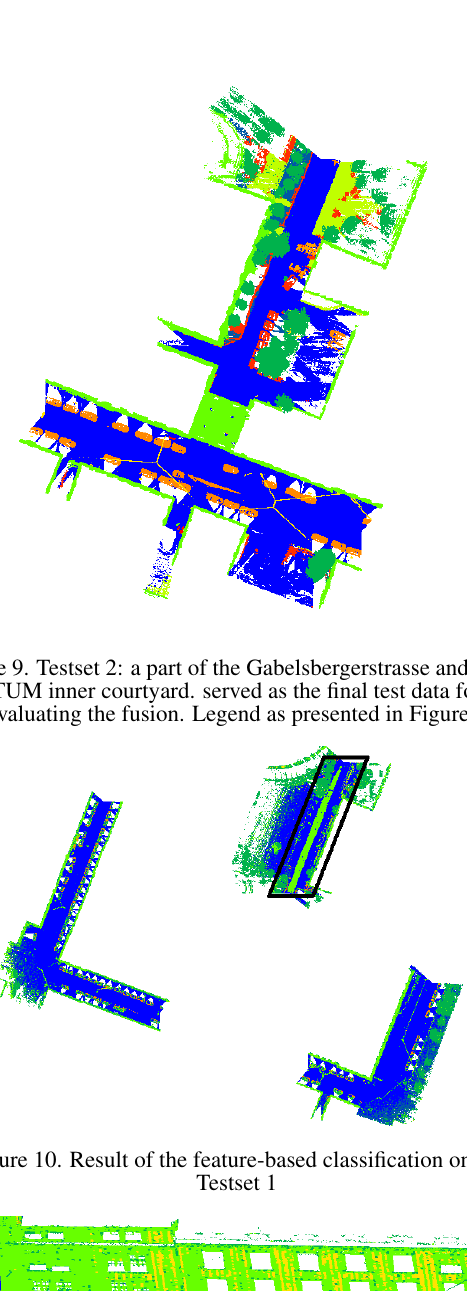
Figure 8. Testset 1: parts of Luisenstrasse and Gabelsbergerstrasse and a part of TUM inner courtyard. Used for deciding between the two methods for labels of each class. Legend as presented in Figure 7 resolution for capturing the context of smaller objects and Figure 11. Misclassification of parts of building facade as hard scape (green-yellow patches) three cameras of the used MMS system depict urban